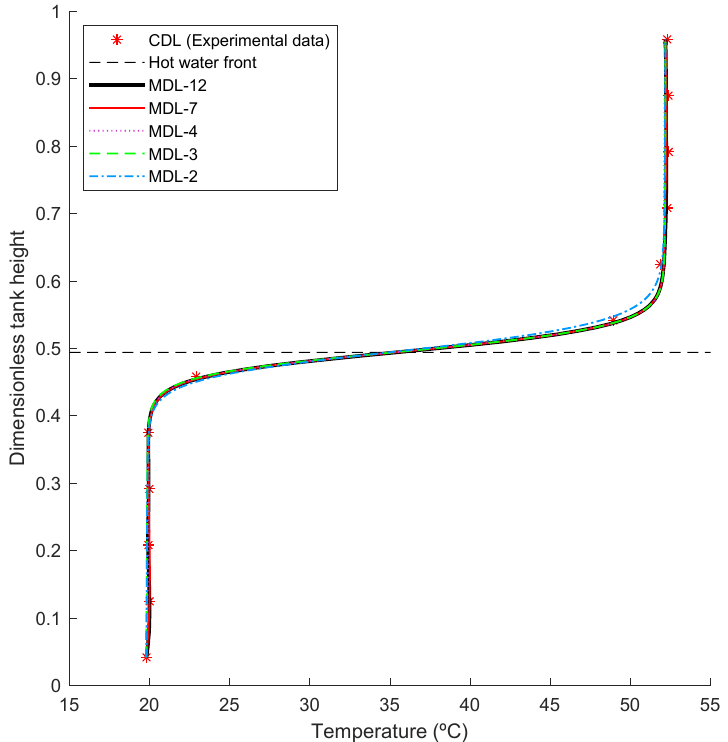
Figure 4. Instantaneous temperature profile at t* = 0.5058 (50.58% of the total tank volume replaced) in CD at low flow rate. Experimental data (CDL) and results derived from the five MDL models which used the data provided from 12, 7, 4, 3 and 2 TC, respectively.